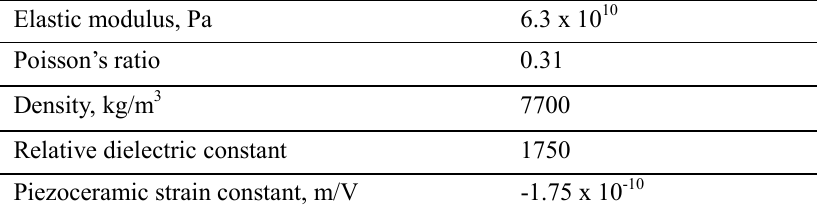
Table 3. Properties of piezoceramic disk material – PZT-5A Elastic modulus, Pa Poisson’s